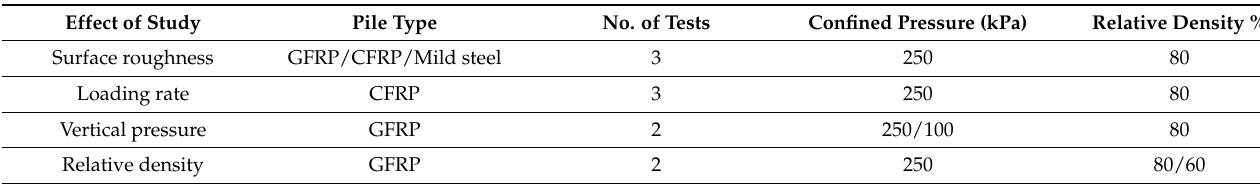
Table 2. Program for the effect under axial load.